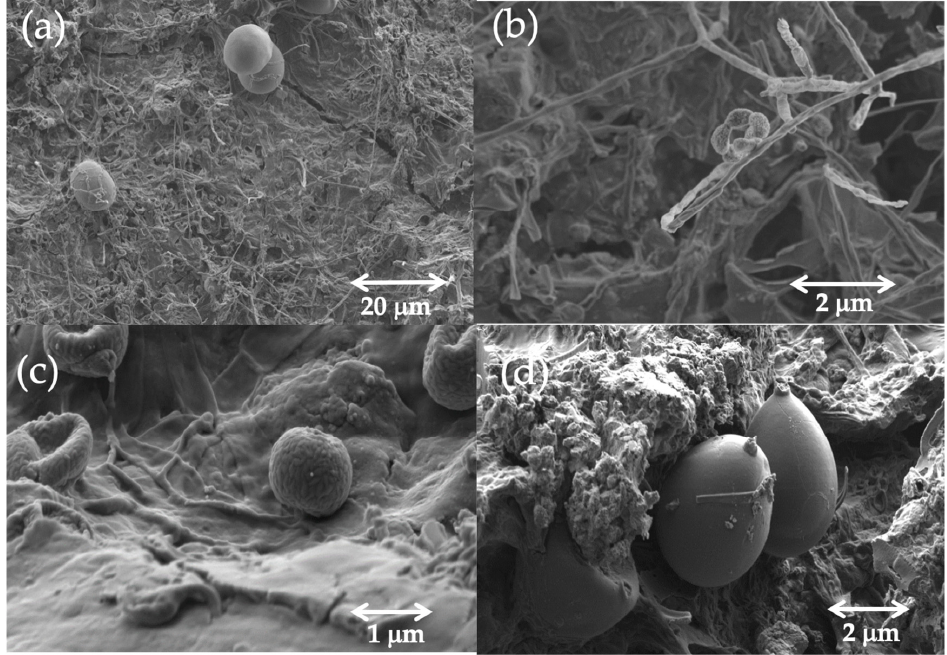
Figure 8. Secondary electron image of hyphae and spores on the surface of the sample: ( a ) F-1; ( b ) F-1; ( c ) D-1; ( d ) K-4.